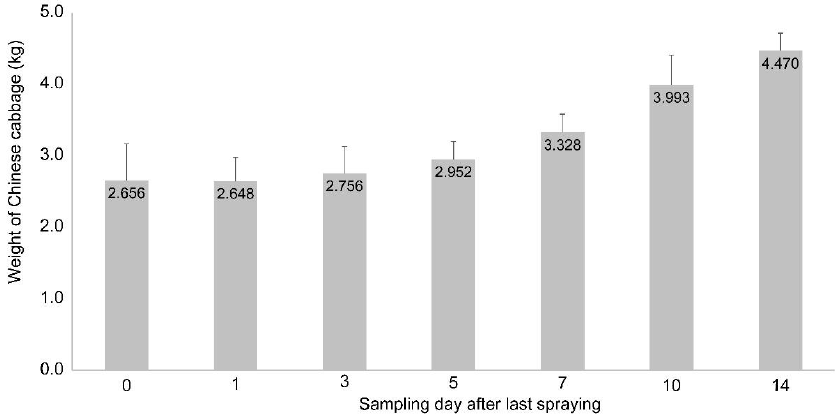
Figure 3 . Weight with standard deviation (n = 10) of Chinese cabbage throughout the sampling period in plot 2.